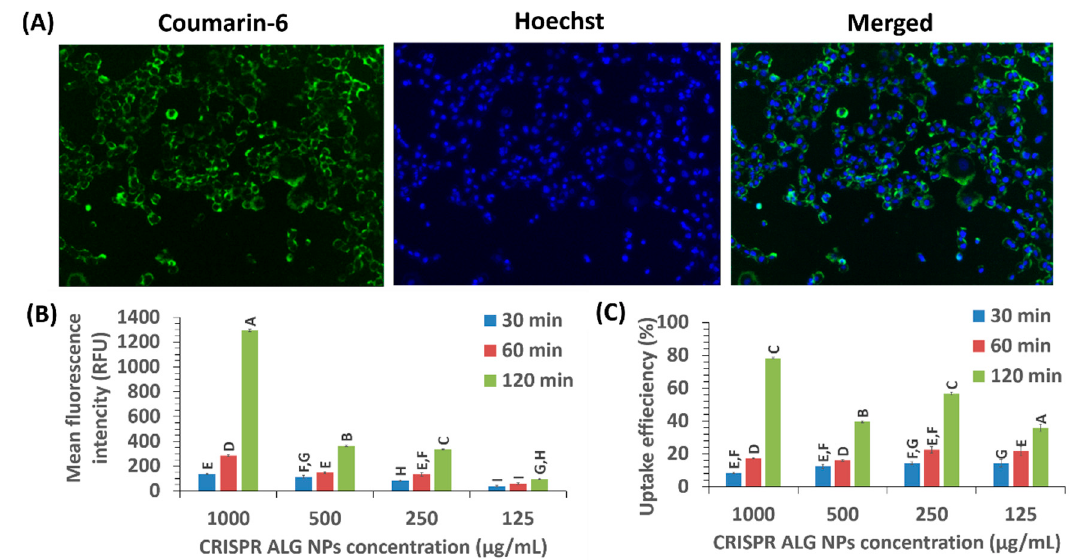
Figure 9. ( A ) The cellular uptake of coumarin-6 loaded NPs in HepG2 cells at concentration 100 µg/mL at 37 °C for 2 h. The cell nuclei stained with Hoechst, and green color was the intrinsic fluorescence from courmarin-6. ( B ) The mean fluorescent intensity of NPs by HepG2 cells at various concentrations for 30, 60, 120 min. ( C ) Cellular uptake efficiency of NPs by HepG2 cells at various concentrations for 30, 60, 120 min. Letter denotes significance, whereby groups that do not share a letter are significantly different p < 0.05 ( n = 3).